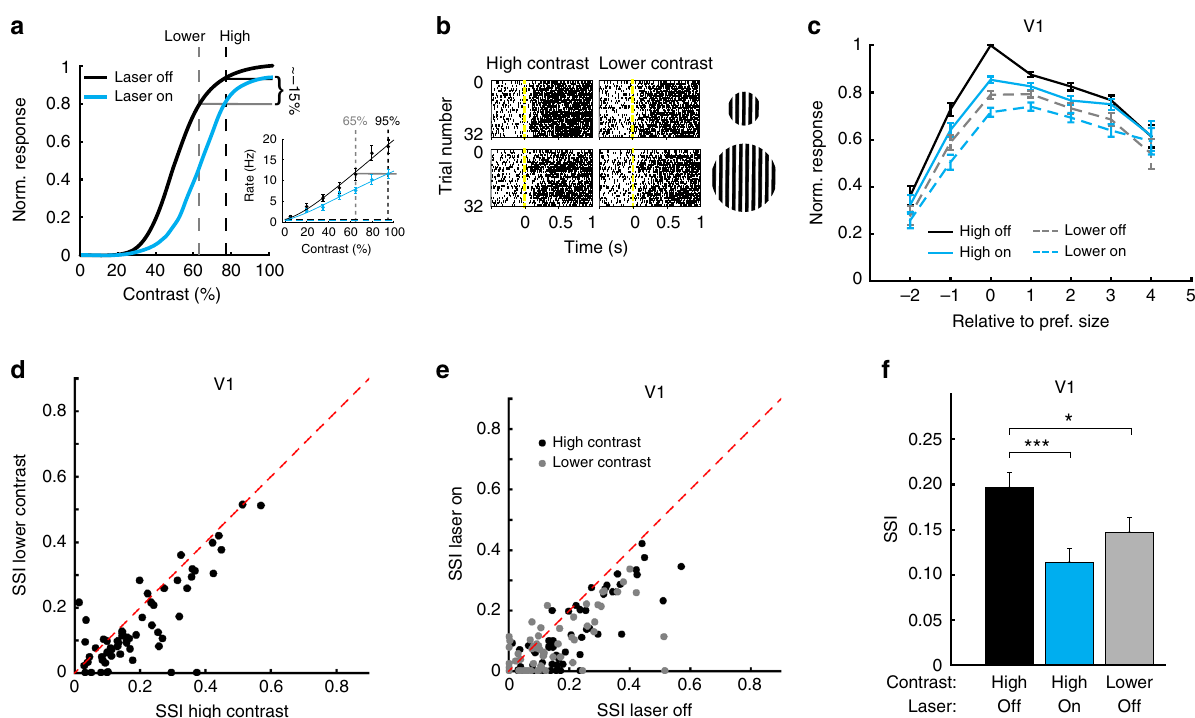
Fig. 5 Lowering contrast reduces V1 surround suppression like optogenetically inhibiting sSC. a Contrast tuning in V1 was measured for an optimal size stimulus, without (black) and with (blue) optical inhibition of the sSC. The highest contrast at which the population response showed a reduction of approximately 15% was set as high contrast level. The contrast level at which the population gave a roughly equal response when the sSC is not inhibited was set as lower contrast level. Inset, example contrast tuning curve for one V1 unit. b Example rastergram of V1 neuron for gratings shown at two sizes at high (90%) and lower (70%) contrast. Different lines show different trials with different drifting directions. Stimulus started at time 0. c Population average size tuning curves for lower contrast resembled the size tuning curve at high contrast with optogenetic inhibition of the sSC. All responses were normalized to the response of the preferred stimulus at high contrast, without optogenetic inhibition of the sSC. Error bars indicate s.e.m. d Surround suppression was lower at lower contrast ( p = 3.4 × 10 -7 , Wilcoxon test; 5 mice, 63 units). e Optogenetic inhibition of the sSC reduced V1 surround suppression for high and lower contrasts. f Surround suppression for high contrast without and with optogenetic inhibition of sSC and for lower contrast without optogenetic inhibition of the sSC (change by inactivating sSC, p = 0.00019; change by lowering contrast p = 0.041; difference between inactivated sSC condition and lower contrast: p = 0.19, all Bonferroni-corrected Mann – Whitney U -tests). Bars indicate mean and s.e.m.; * p < 0.05, *** p <